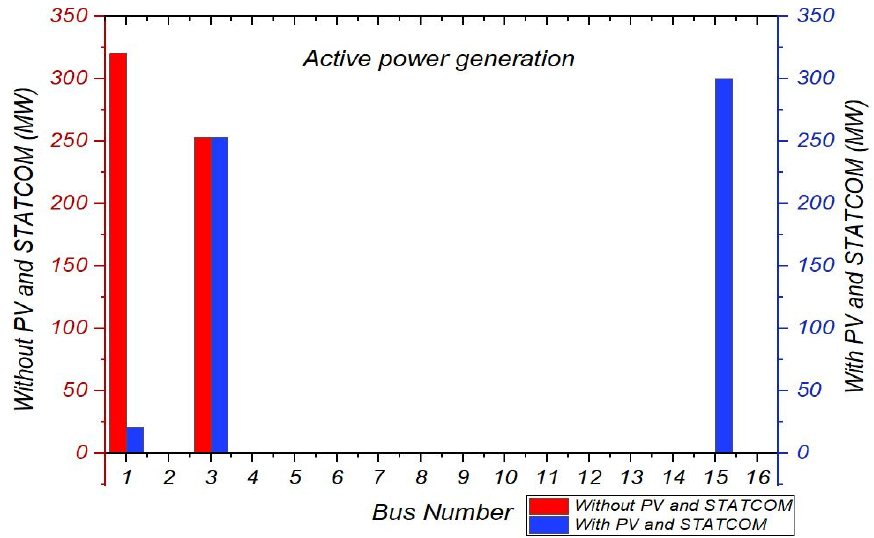
Figure 26. Active power generation without and with SPVGP and